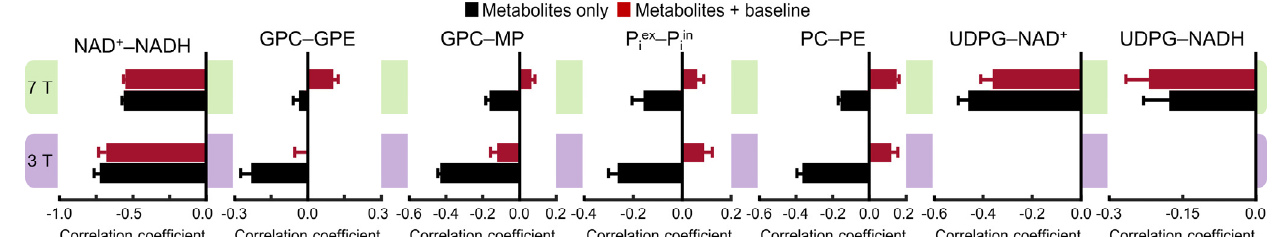
Figure 4. Mean cross-correlation coefficients for representative pairs of metabolites derived from Monte Carlo analysis of the 3 Tesla (n = 5) and 7 Tesla (n = 5) 31 P MRS spectra. Monte Carlo analysis was performed for two different scenarios: metabolites only (black) and metabolites + baseline (dark red). Error bars represent standard deviations.